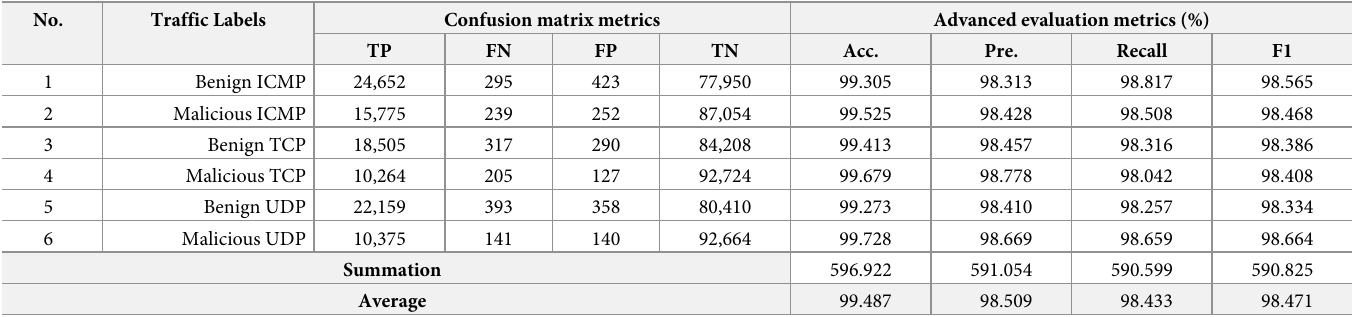
Table 10. SDN metrics of the above confusion matrix.